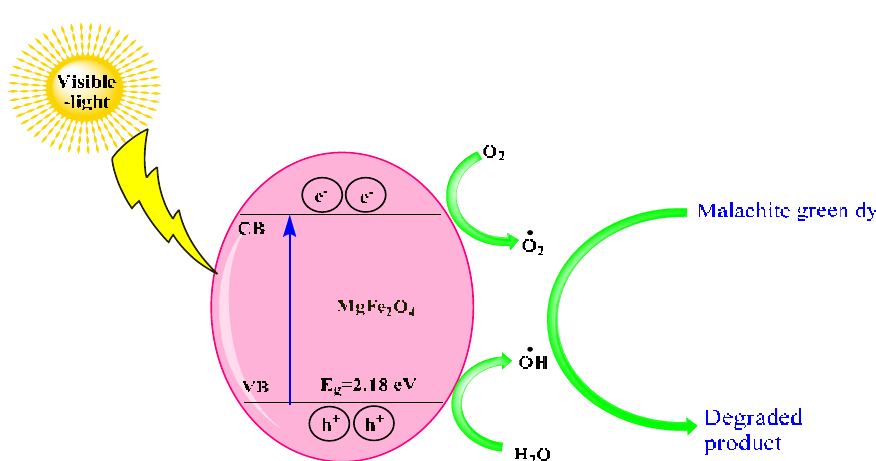
Fig. 8. Recyclability of MgFe Figure 8. Recyclability of MgFe 2 O 4 MNPs (MgFe 2 O 4 = 0.015 g, MG =20 mg/L).